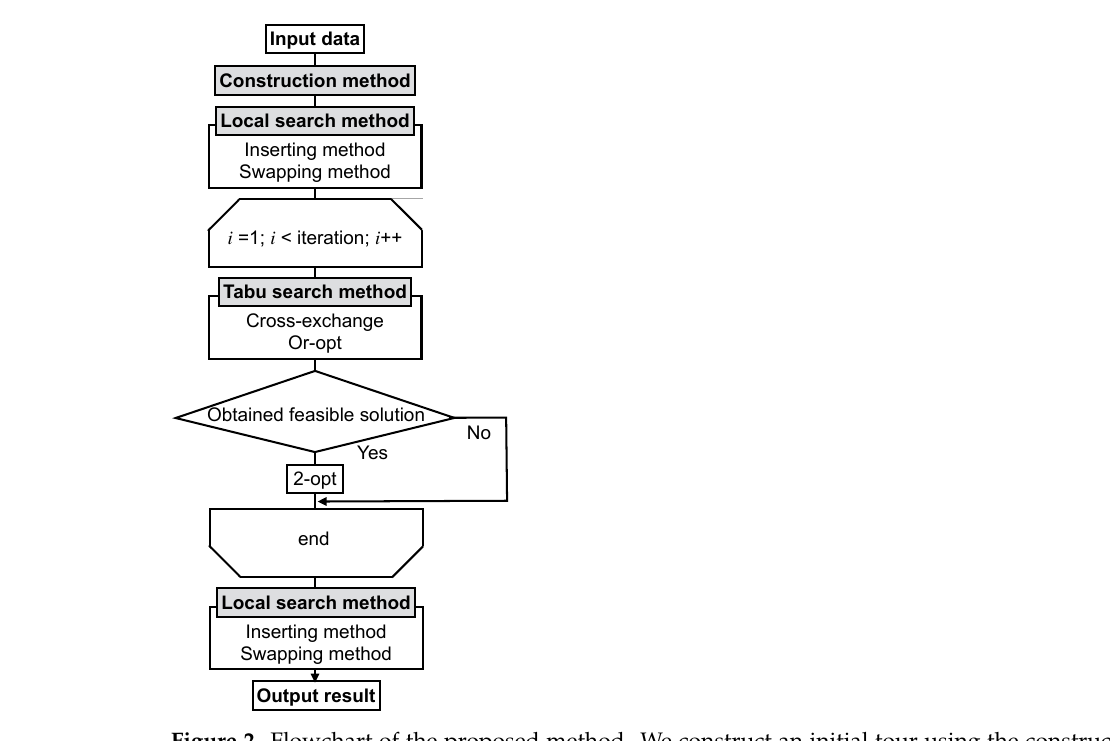
Figure 2. Flowchart of the proposed method. We construct an initial tour using the construction method. Then, we improve the initial tour using the inserting method and the swapping